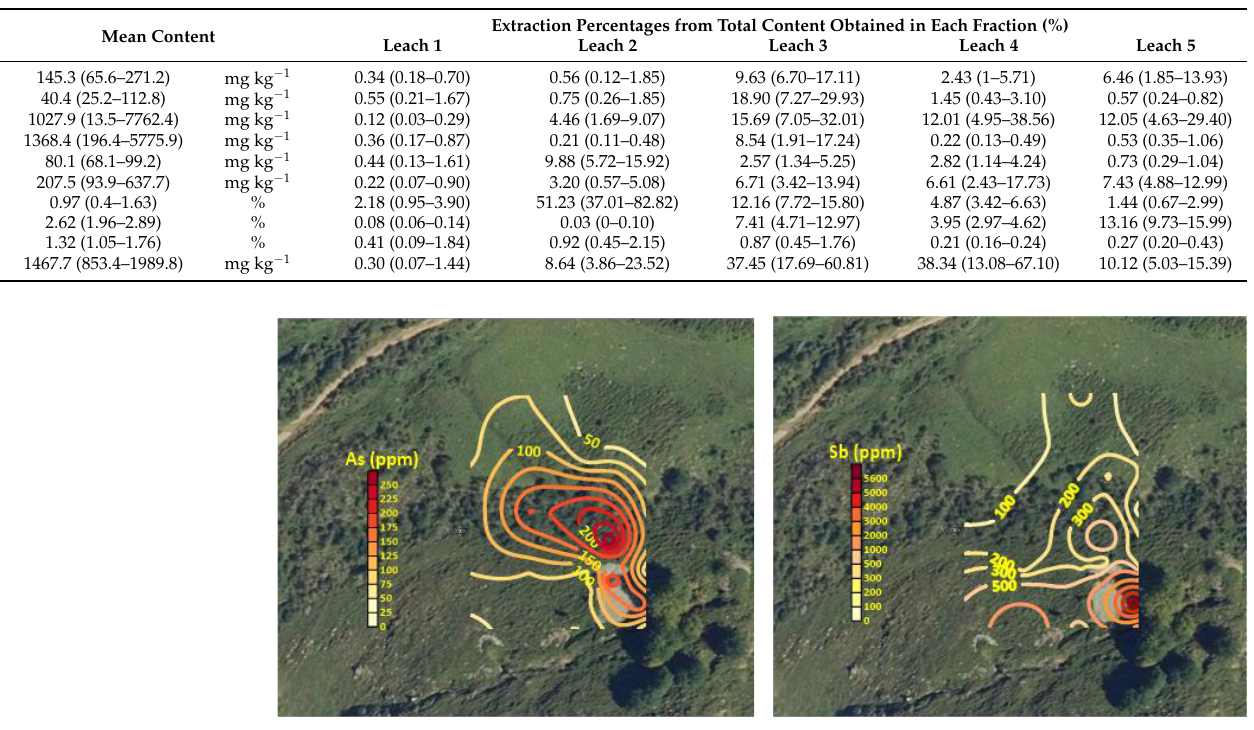
Table 1. Column 2: Average content of selected elements in the sampled soils. Columns 3–7: Average extraction percentages from total content obtained in each step of the SEP. Ranges of values are indicated in the brackets.